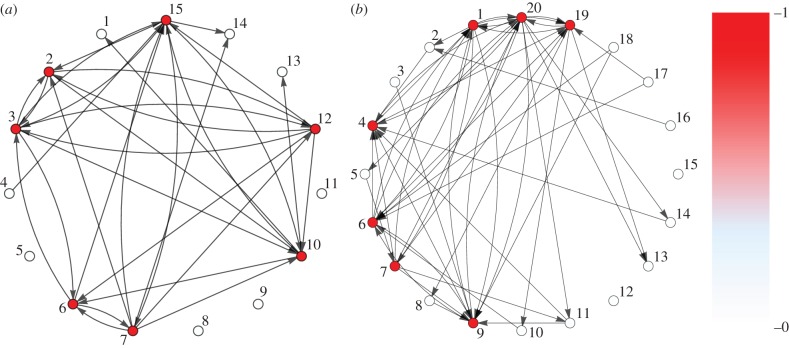
Evolved learning networks. Example of evolved networks with n = 15 (a) and n = 20 (b) neuronal loci. Darker nodes indicate higher frequency of active neurons. In both cases, the particular node labels are irrelevant, and the proportion of active neurons depends on the initial conditions and the history of the process. Note that, irrespective of the number of neuronal loci, the number of active components is correct. Parameters as in figure 4.